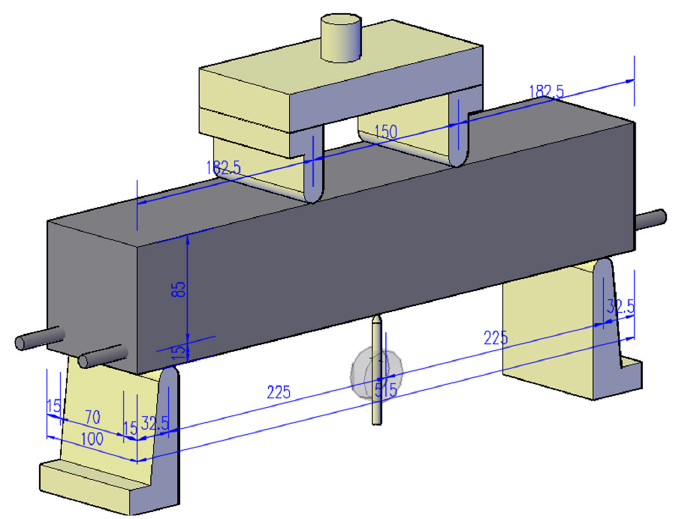
Figure 2. Loading test device (Unit: mm).